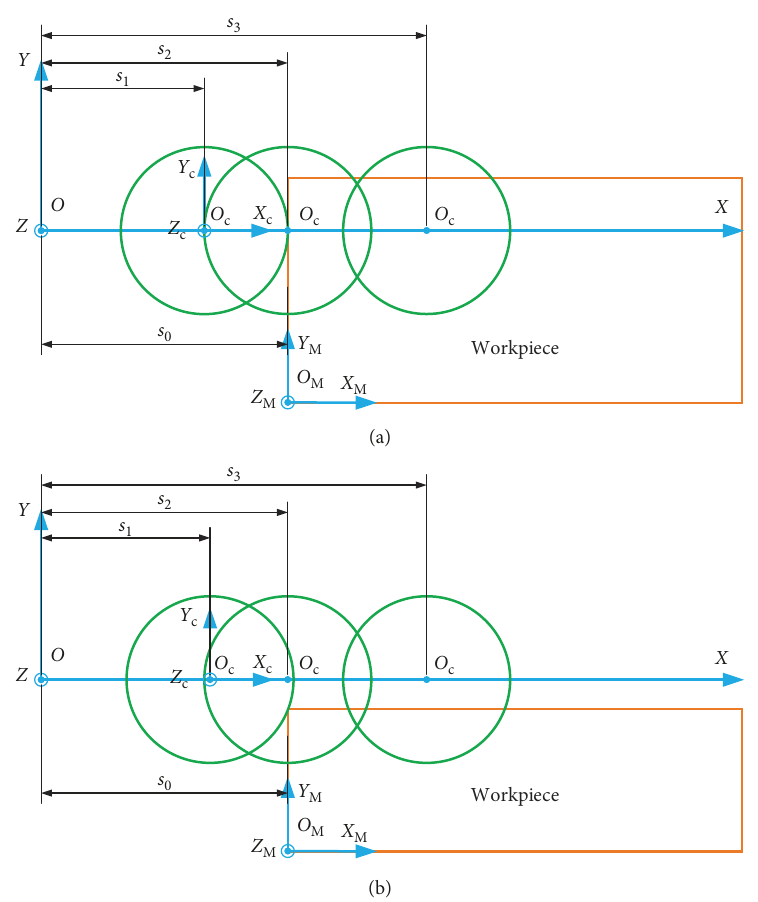
Figure 7: Cutter entering process with different radial cutting depths. (a) a